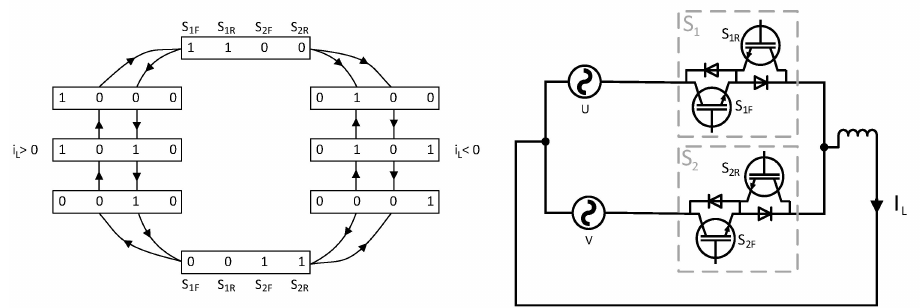
Figure 8. Flow diagram of the four-step commutation for positive and negative output currents.